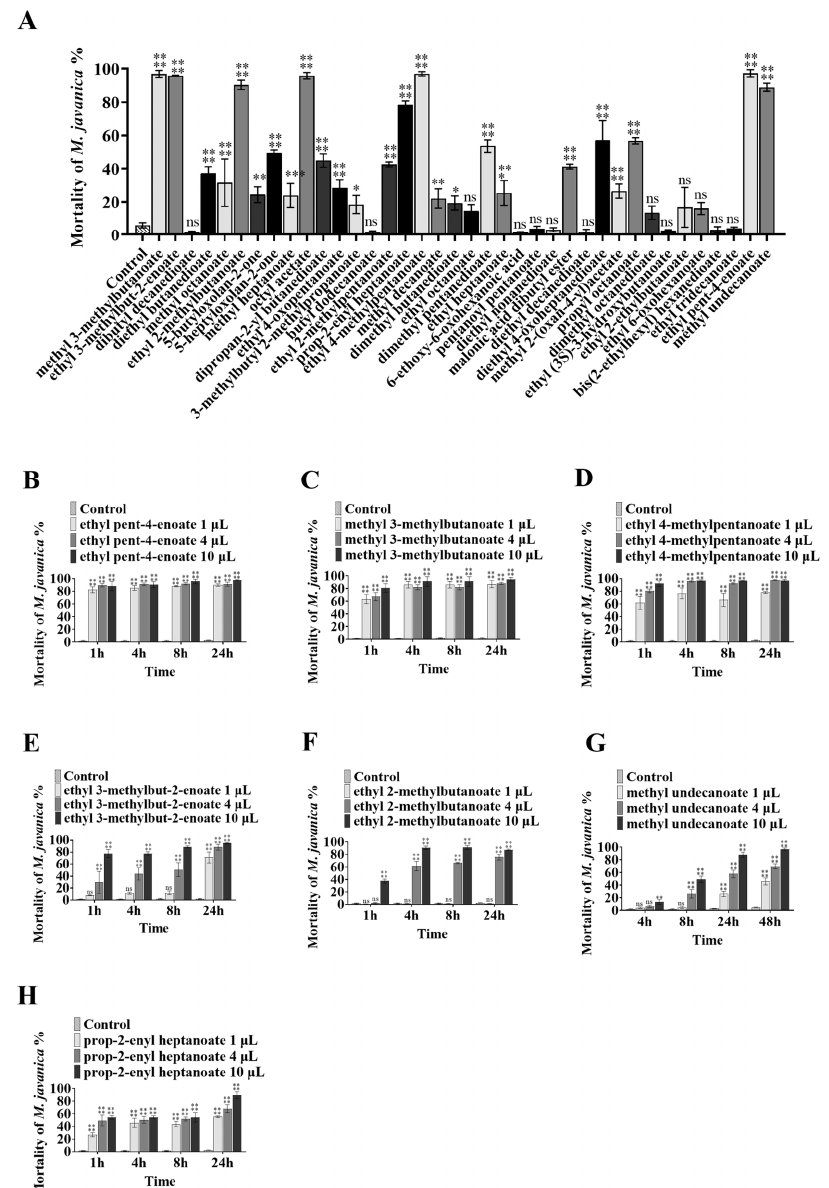
Figure 3. The mortality of nematodes treated with different VOCs at different doses. Bars represent the standard error of the means (n = 3). The asterisk symbols above the columns signify significant differences using ANOVA, **** mean p < 0.0001; *** mean p < 0.001; ** mean p < 0.01; * mean p < 0.05: ( A ) treatment with different VOCs; treatment with different doses of ( B ) ethyl pent-4-enoate, ( C ) methyl 3-methylbutanoate, ( D ) ethyl 4-methylpentanoate, ( E ) ethyl 3-methylbut-2-enoate, ( F ) ethyl 2-methylbutanoate, ( G ) methyl undecanoate, and ( H ) prop-2-enyl heptanoate.